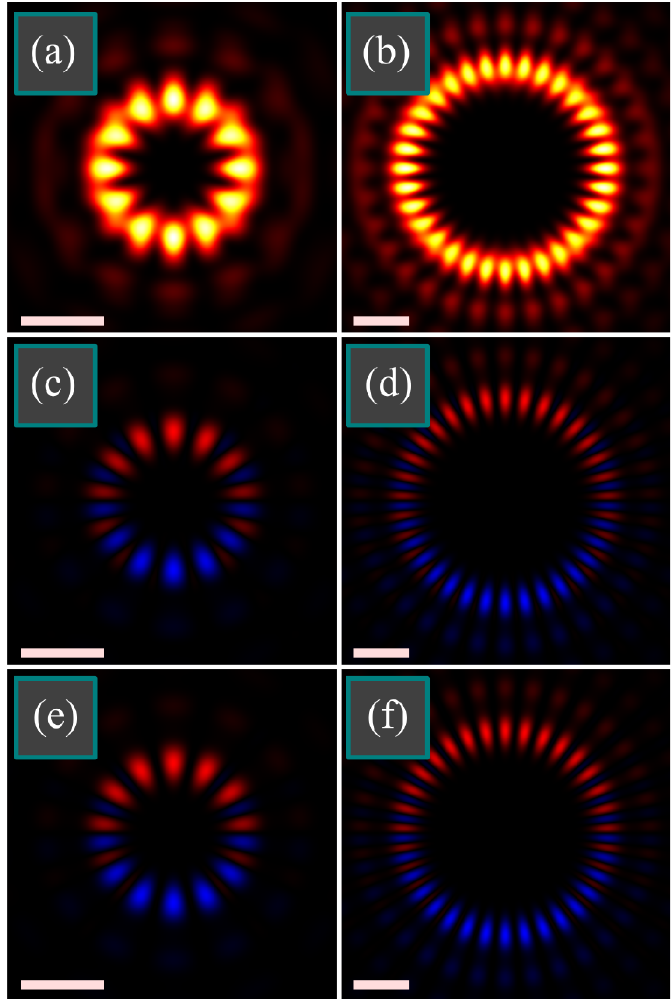
Figure 5. Distributions of intensity | E x | 2 + | E y | 2 + | E z | 2 ( a – b ) and of longitudinal SAM density 2Im{ E x * E y } ( c – f ) of tightly focused light field with double-index polarization singularity of the orders ( m , n ) = (6, 7) ( a , c , e ) and ( m , n ) = (16, 17) ( b , d , f ) at the following parameters: wavelength λ = 532 nm, focal length of the lens f = 10 μ m, numerical aperture sin α = 0.95, amplitude apodization function is homogeneous, i.e., A ( θ ) ≡ 1. SAM distributions were computed directly by Equation (8) ( c , d ) and by an approximate Equation (20) ( e , f ). Figures have the size 4 × 4 μ m 2 ( a , c , e ) and 6 × 6 μ m 2 ( b , d , f ) (scale mark shows 1 μ m). Light and dark colors in the intensity distribution mean maximum and zero. Red and blue colors ( c – f ) mean, respectively, positive and negative SAM.